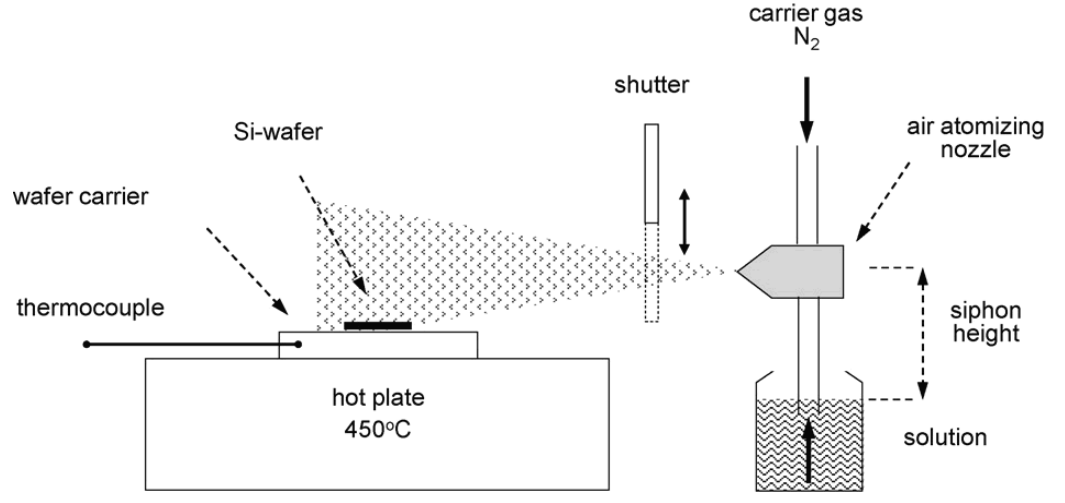
Figure 5. Demonstrating the spray pyrolysis technique for depositing thin films. Figure adapted with permission from Tischner et al.